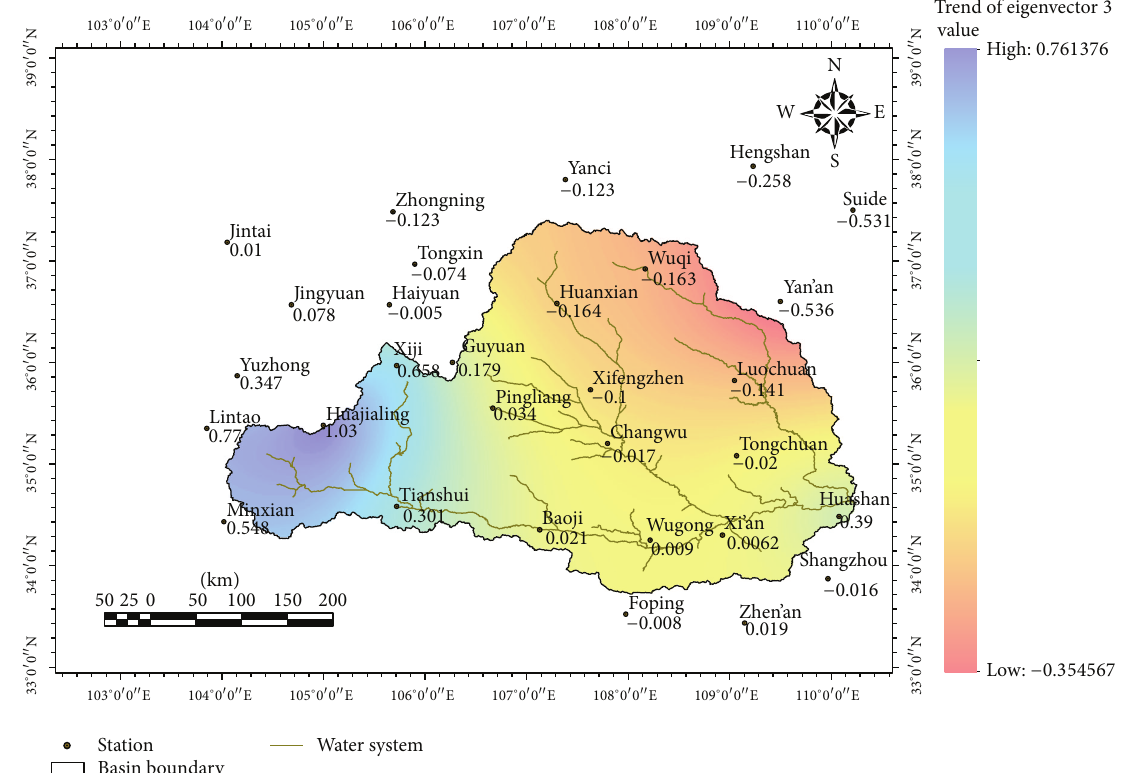
Figure 7: The eigenvector 3 trend field for annual precipitation in the Weihe